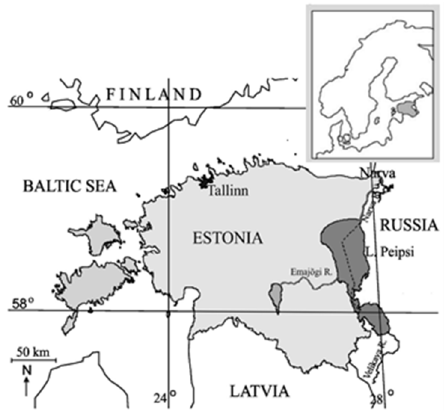
Figure 1. Location of Lake Peipsi. Table 1. Selected characteristics of Lake Peipsi at a mean water level of 30 m above sea level (after Jaani [52]). Nutrient (surface water 0–1 m), chlorophyll a (integral sample) and water transparency